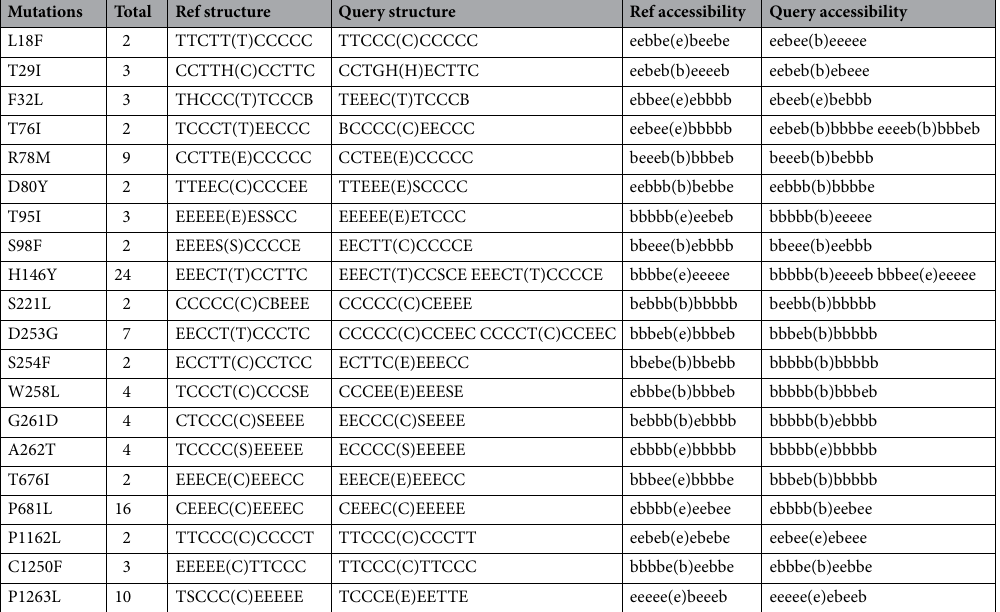
Table 12. Gene S—nonsynonymous mutations that have both structure and solvent accessibility change potentials occuring in 2 or more sequences. The “Query Structure” (and “Query Accessibility”) shows the unique structure (and accessibility) changes based on on prediction results. Structure letter in parentheses is the predicted structure of the residue at the corresponding mutation position. Five letters before and after parentheses are structures of neighbouring residues. Likewise, letter “b” or “e” in parentheses shows the accessibility status of the residue at the mutation position.